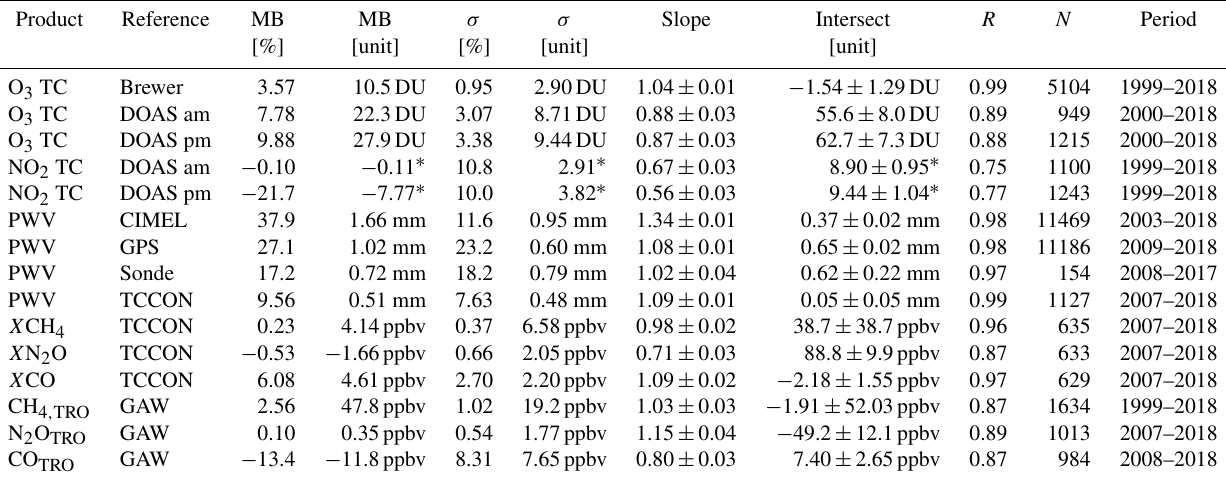
Table 4. Summary of intercomparison between the FTIR products and the IZO reference data sets: reference technique, mean bias (MB, in % and absolute units), standard deviation of the differences ( σ , in % and absolute units), slope and intersect of the least-squares fit ( Y is FTIR and X is reference), Pearson correlation coefficient ( R ), number of coincidences ( N ), and coincident period. The differences are computed with respect to the reference IZO observations: (FTIR − Reference) in absolute units and (FTIR − reference) / reference in %. The ∗ means 10 14 molec.cm − 2 . Note “am” refers to morning and “pm” refers to